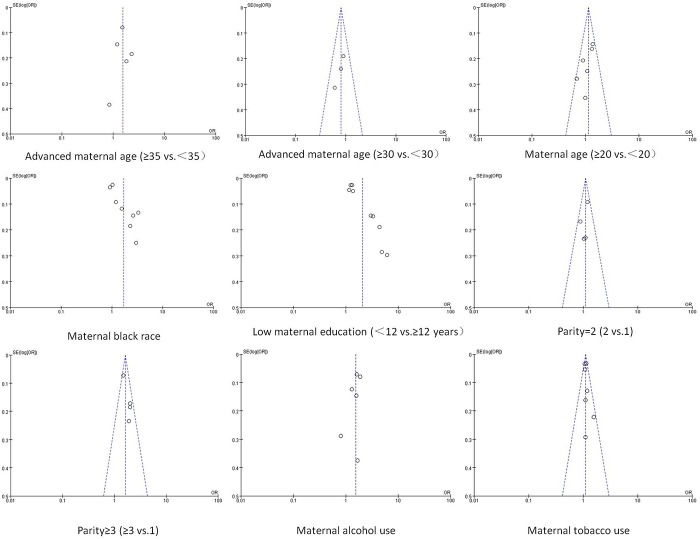
Funnel plot for publication bias test.The two oblique lines indicate the pseudo 95% confidence limits.